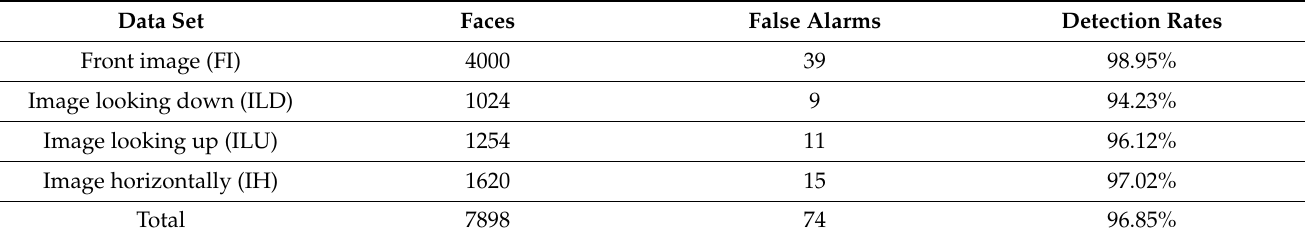
Figure 7. Results of face recognition in some images ( a ), ( d ) belonging; ( b , c , e ) different lighting conditions, ( f ): different angles. Table 3. False positives and detection frequency from the